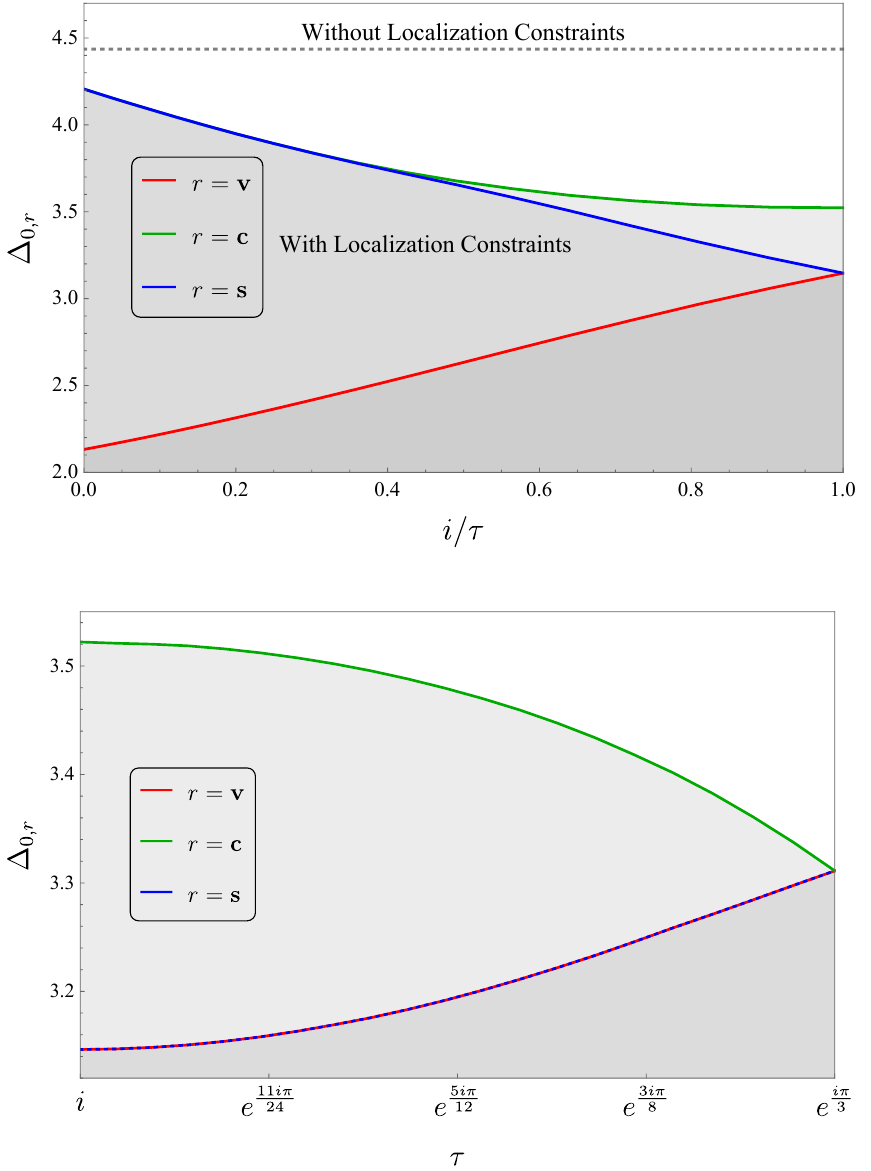
Figure 3 . Upper bounds on the scaling dimension ∆ 0 ,r of the lowest scalar in irreps r = 35 c , 35 s , 35 v as a function of i/τ from the free point τ = i ∞ until the S -duality invariant point τ = i with < ( τ ) = 0 ( top ), and as a function of τ along the S -duality invariant arc with | τ | = 1 from τ = i to the T -duality invariant point τ = e πi/ 3 ( bottom ). These bounds were computed with bootstrap resolution Λ = 27 , as defined below (4.12). Note that the triality related bounds in different duality fundamental domains are related as in (3.22). We also show the upper bounds that would be obtained at the same bootstrap resolution without using the integrated constraints, which are the same for 35 c , 35 v , and 35 s